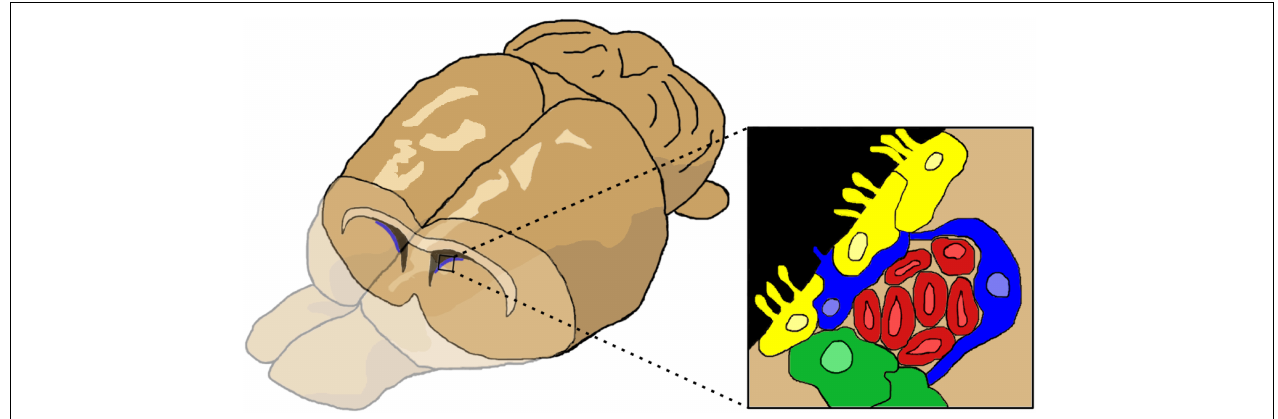
FIGURE 1 | The cells of the subventricular zone (SVZ). The SVZ is located just below the lateral ventricles. Cells (inset) consist of ependymal cells (yellow), type B or astrocytes (blue), type C or transit amplifying cells (green), and type A cells or neuroblasts (red). Figure inspired by García-Verdugo et al. (1998), Ihrie and Álvarez-Buylla